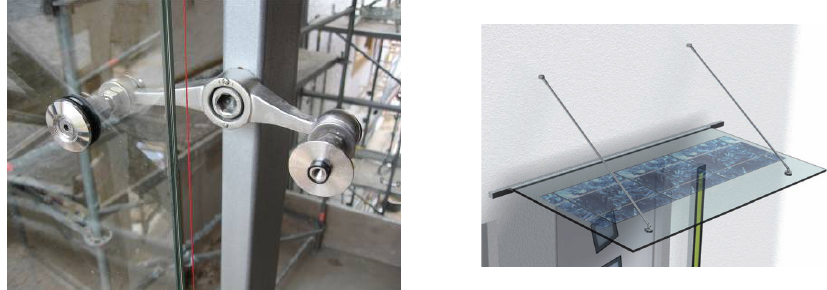
Figure.4: point fixing with tolerance compensating „spider“ which is fixed to superstructure. Figure 5: point fixed canopy with solar